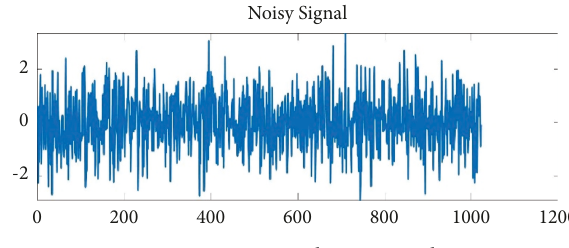
Figure 5: External noise signal.